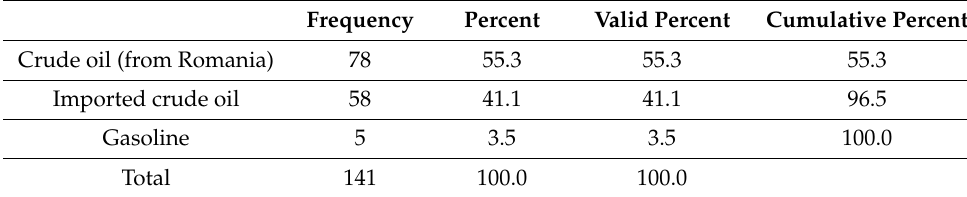
Table 10. Recorded incidents by transported product.